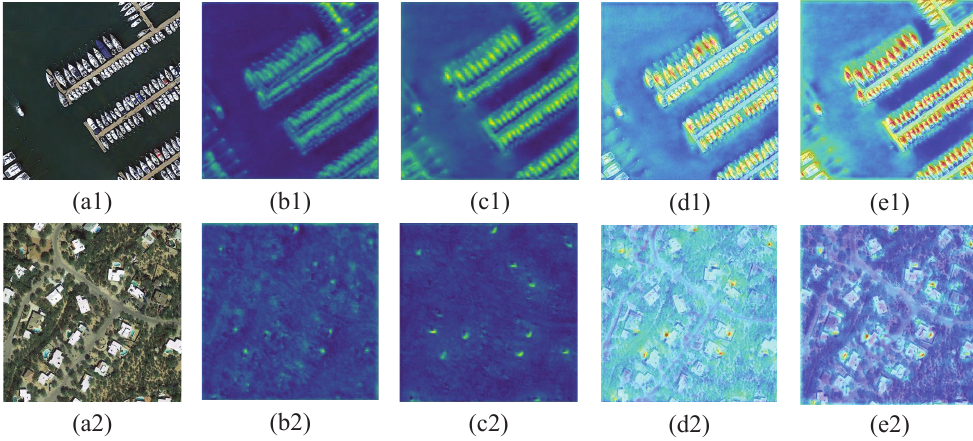
Figure 10. Visualizations of Multi-layer Attention Network. ( a1 , a2 ) The input images. ( b1 , b2 ) The input feature maps of Multi-layer Attention Network. ( c1 , c2 ) The output feature maps of Multi-layer Attention Network. ( d1 , d2 ) The heatmaps of the input feature maps of Multi-layer Attention Network. ( e1 , e2 ) The heatmaps of the output feature maps of Multi-layer Attention